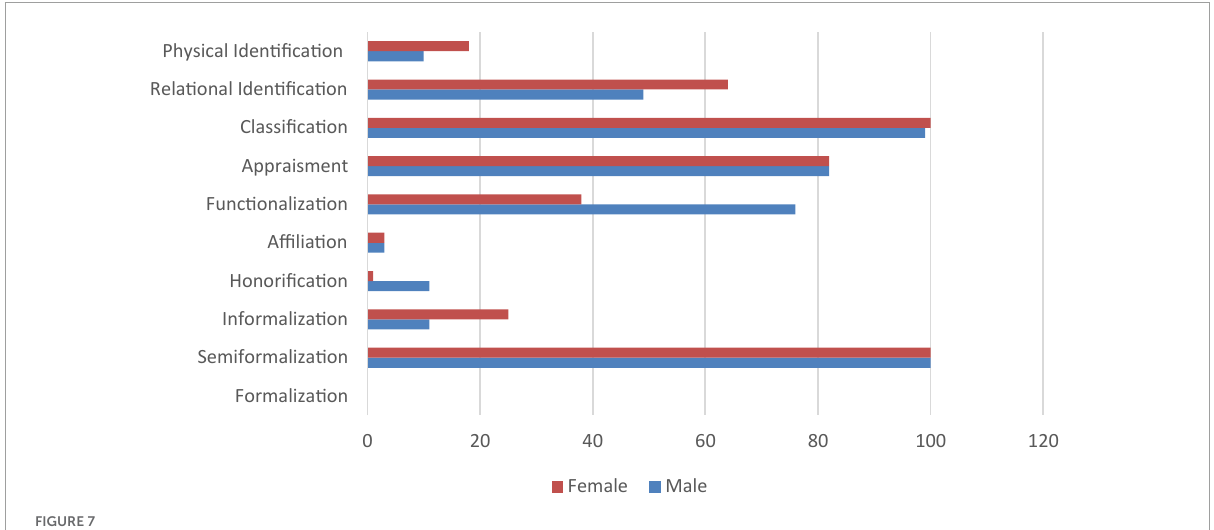
FIGURE7 Social actor representation in a random 200-tweet sample from the